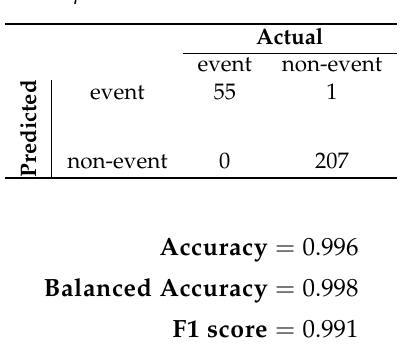
Table 10. Tire Speed Event —confusion matrix for test